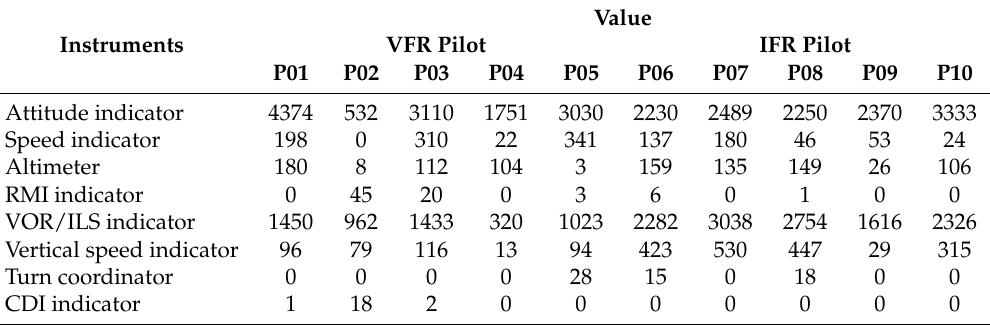
Table 6. The number of fixations registered by the Smart Trainer for the AOI in the VFR and IFR pilot groups.